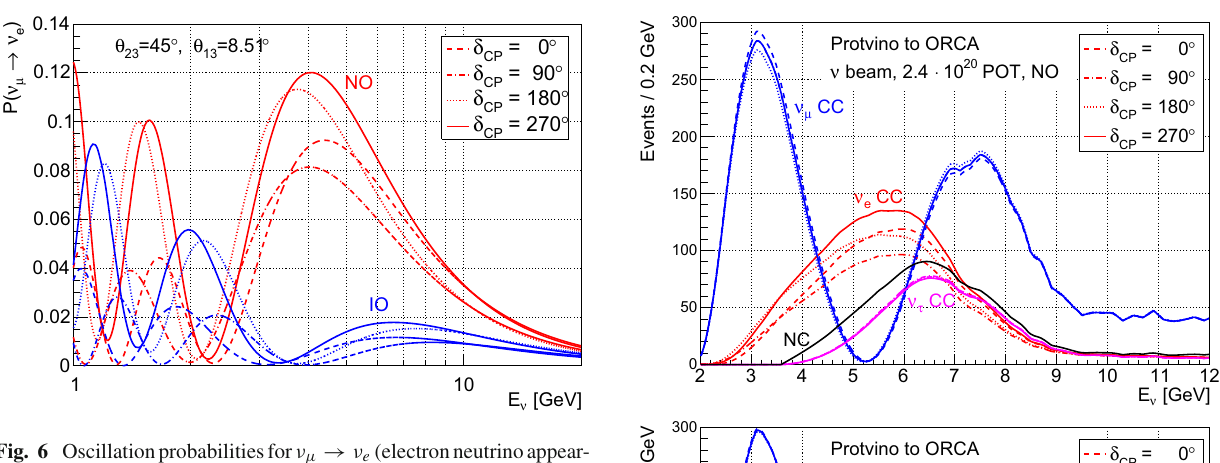
Fig. 6 Oscillationprobabilitiesfor ν μ → ν e (electronneutrinoappear- ance) for a baseline of 2595 km for normal (NO) and inverted (IO) mass ordering